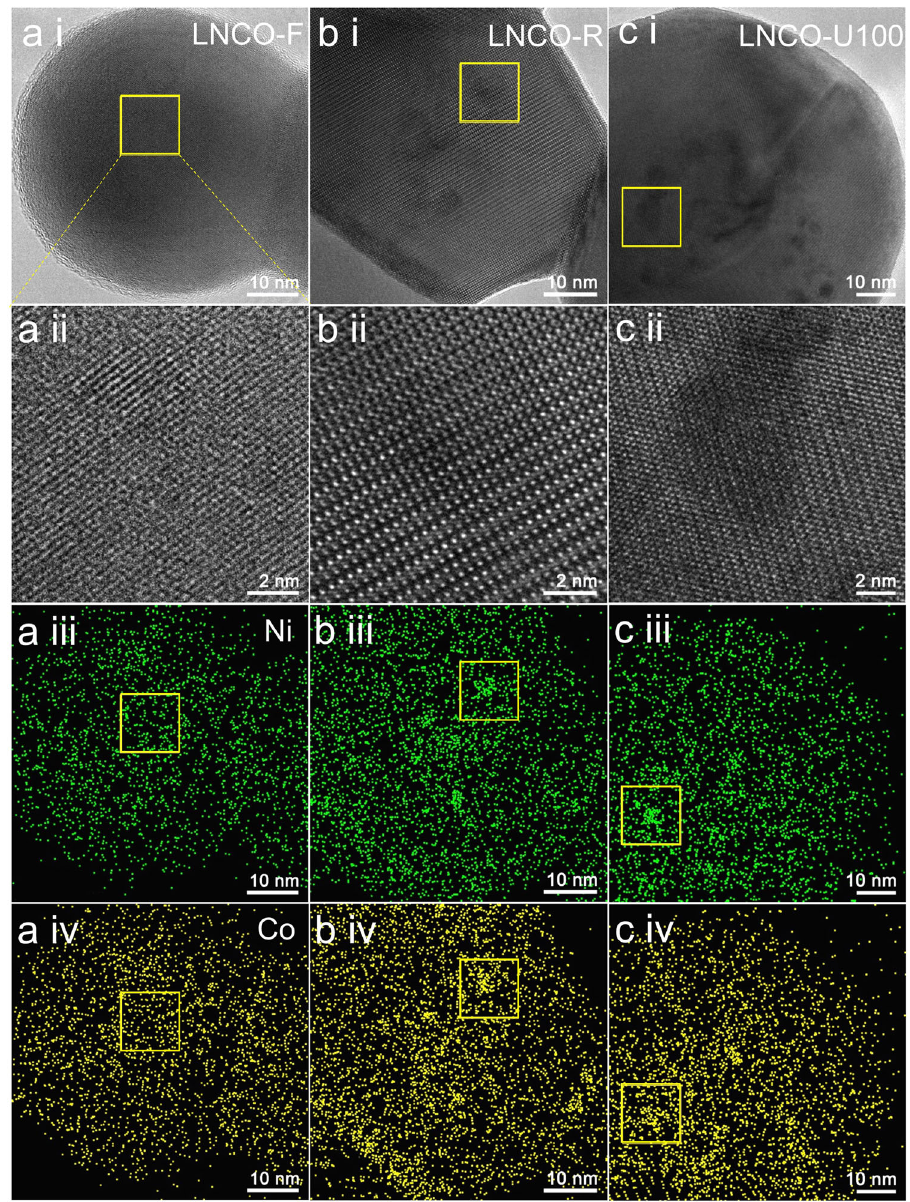
Fig. 4 HR-TEM images and EDS Mapping of Ni and Co of LNCO samples. a LNCO-F, b LNCO-R, and c LNCO-U100 represent fresh, H 2 -reduced, and used after 100 h time on stream LaNi 0.05 Co 0.05 Cr 0.9 O 3 samples, respectively. The 1st row: HR-TEM images, the 2nd row: magni fi ed HR-TEM images corresponding to the yellow squares in the 1st row, the 3rd row: EDS Mapping of Ni corresponding to the HR-TEM images in the 1st row, and the 4th row: EDS Mapping of Co corresponding to the HR-TEM images in the 1st row. The regions marked by yellow squares in ( b , c ) are Ni-rich and Co-rich.